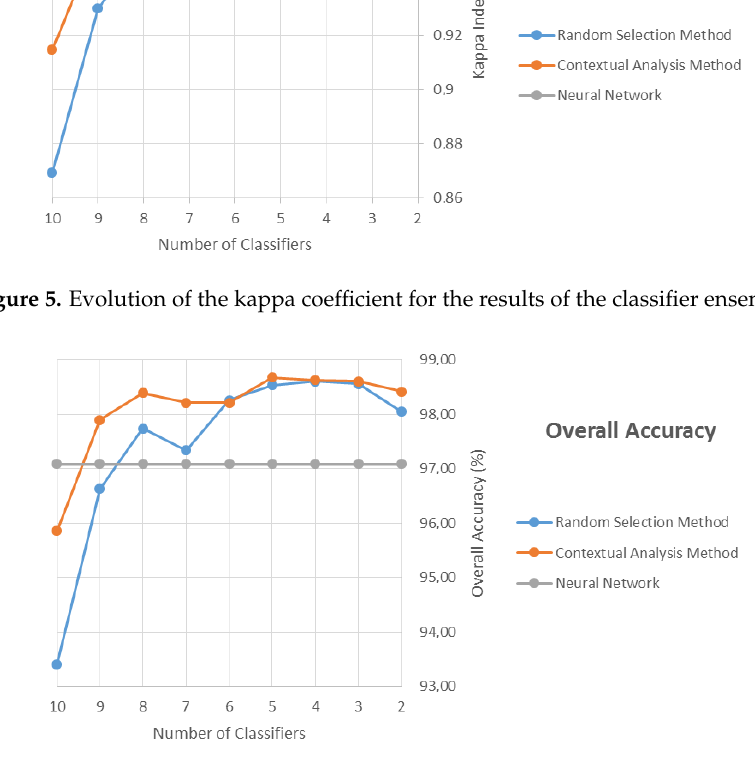
Figure 6. Evolution of the overall accuracy for the classifier ensembles.